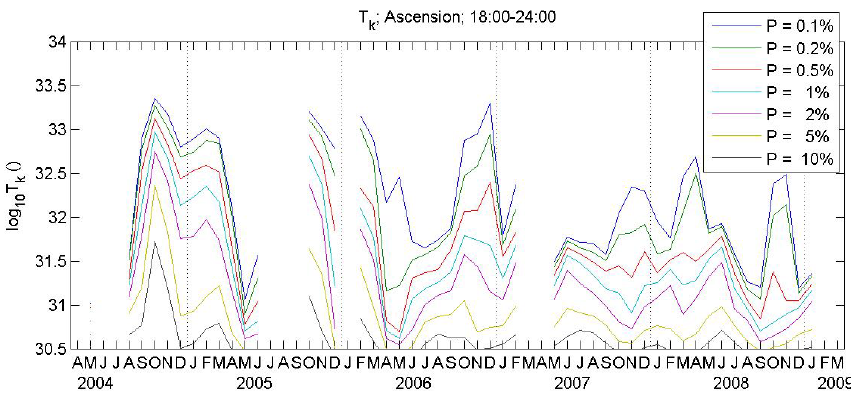
Fig. 3. Values of T k exceeded for various probabilities in Ascension between 18:00 and 24:00, for the months of 2004–2008.